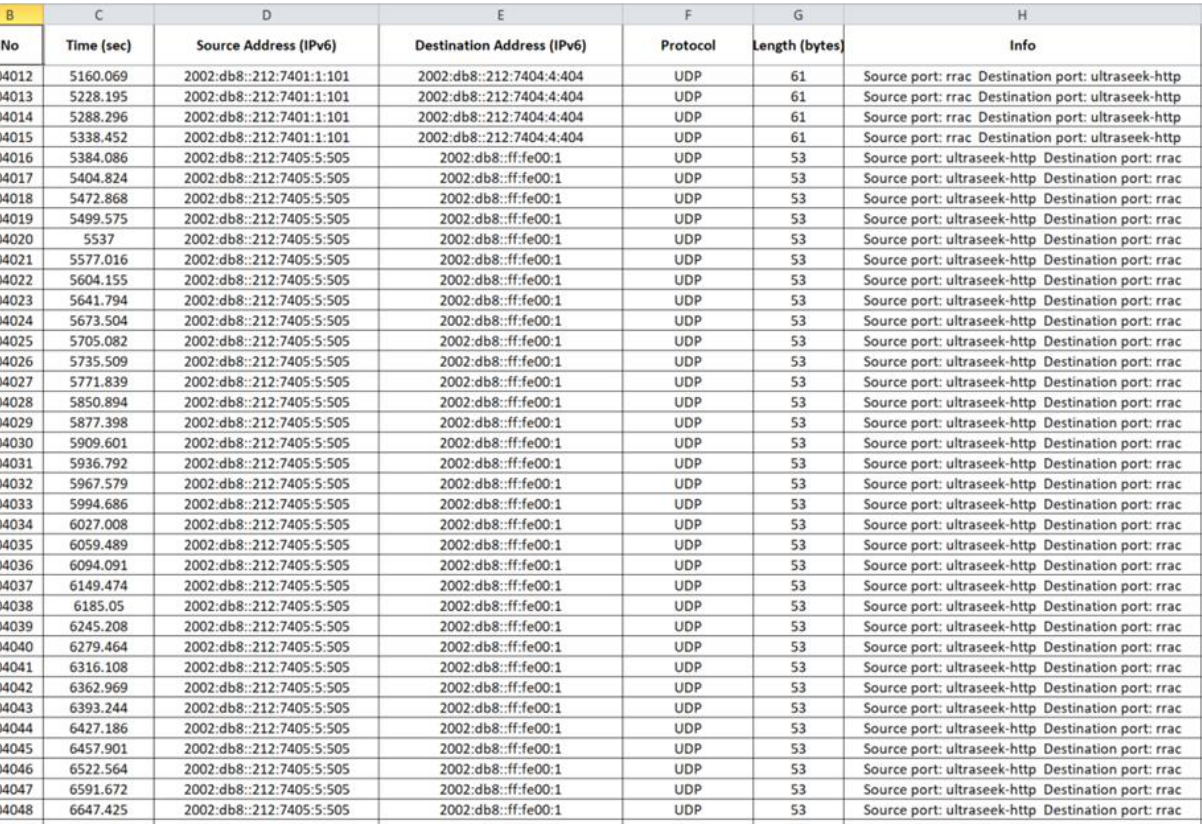
Figure 23. Benign “radiologUDP.csv”— 104,012 to 104,048 records.